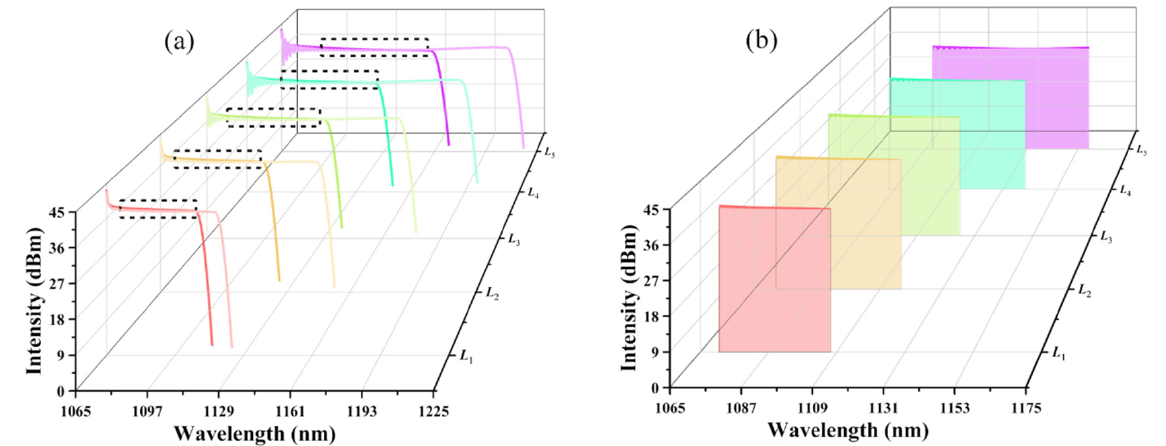
Figure 4. Spectral distribution of DOFC with different crystal lengths L . Crystal length L 1 = 4.0 cm, L 2 = 4.5 cm, L 3 = 5.0 cm, L 4 = 5.5 cm, L 5 = 6.0 cm, m = 200, N = 200, I 0 = 100 MW/cm 2 , I 1 = 1 MW/cm 2 , I 2 = 1 MW/cm 2 . (a) Spectral distribution of DOFC with different crystal lengths L ; the range covered by the dashed box was DOFC within 1 dB flatness. ( b ) Enlargement of the dashed box in ( a ).